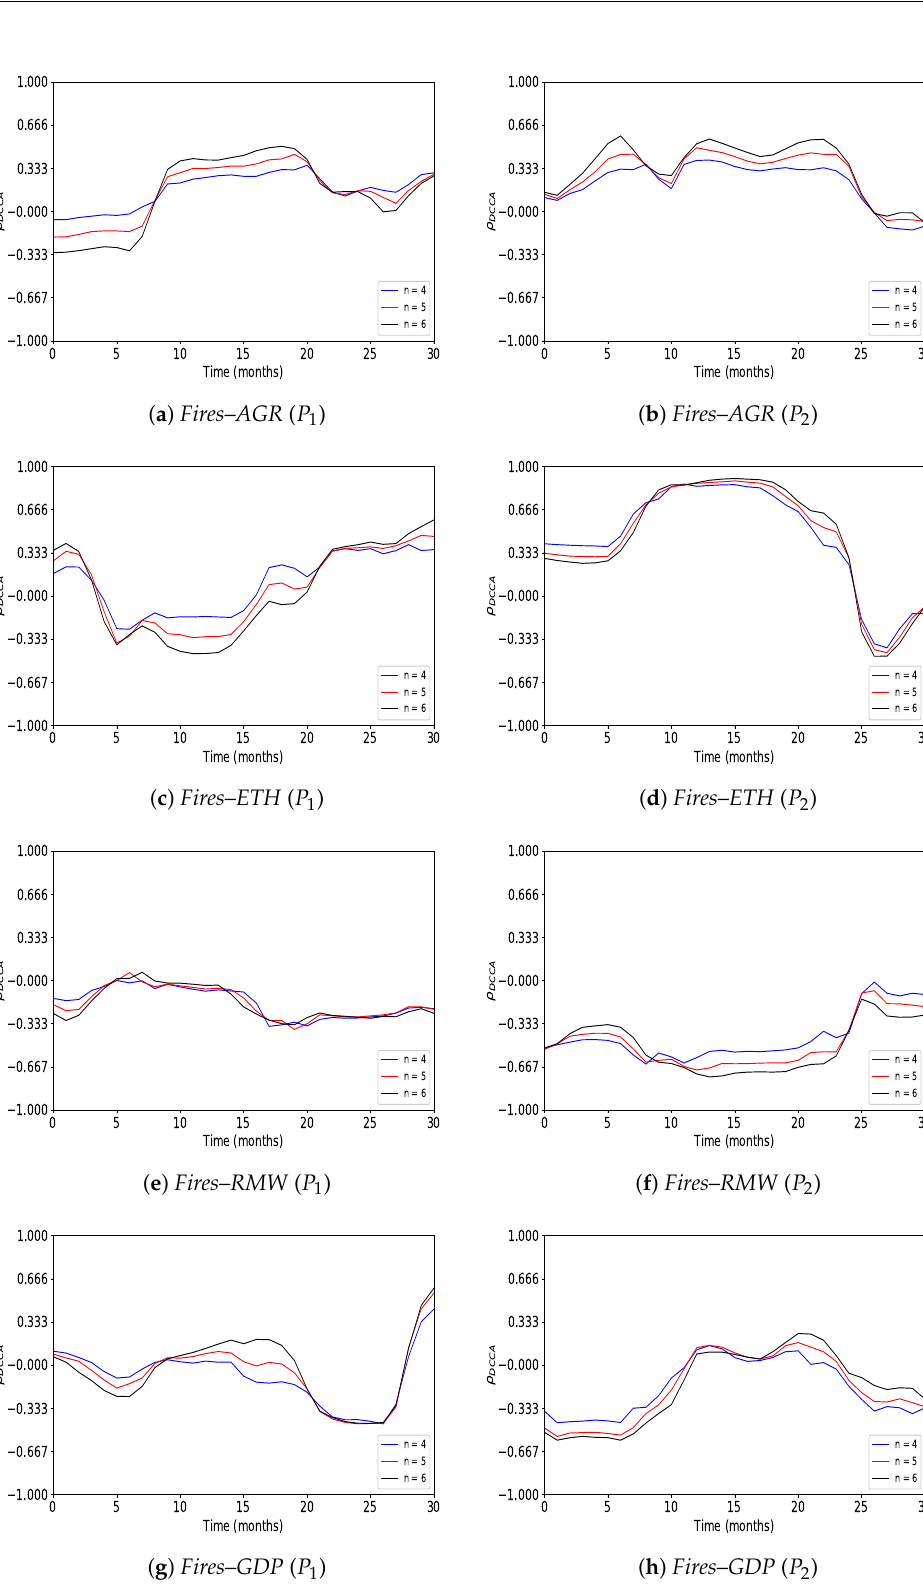
Figure 3. The ρ DCCA comparing the TS of P 1 vs. P 2 for